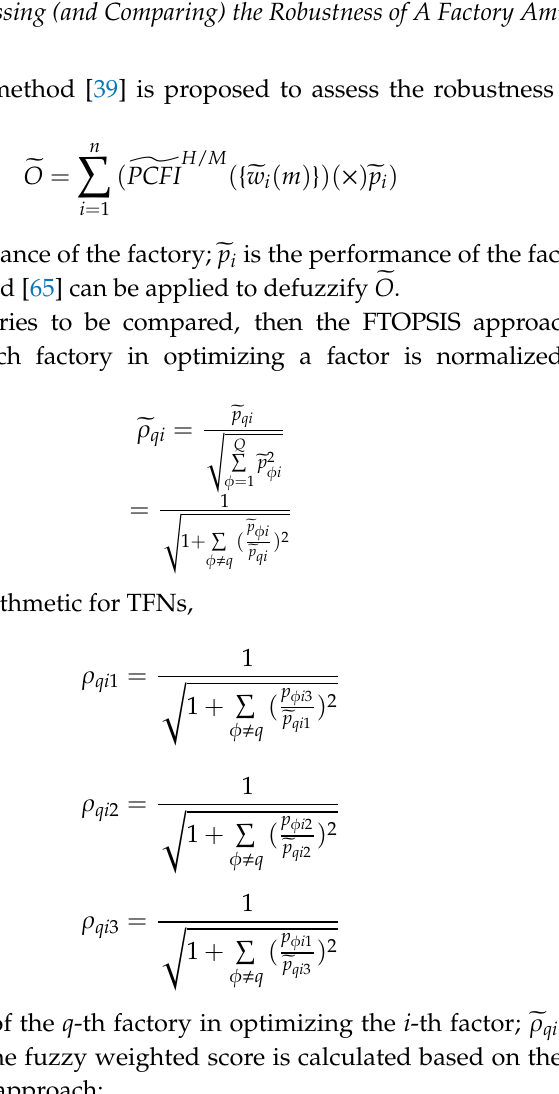
Figure 7. Approximating the PCFI result with a TFN.